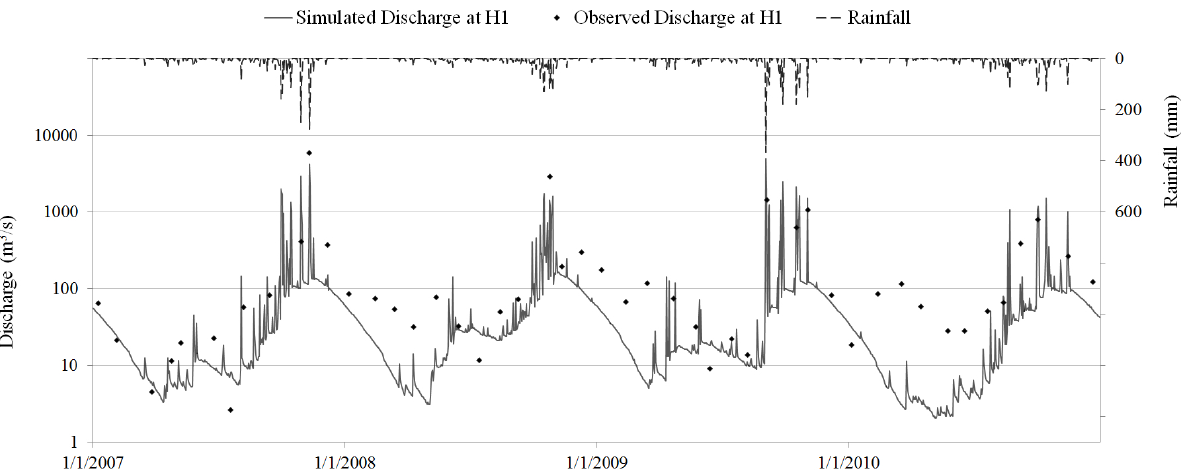
Figure 5. River discharge calibration at H1.